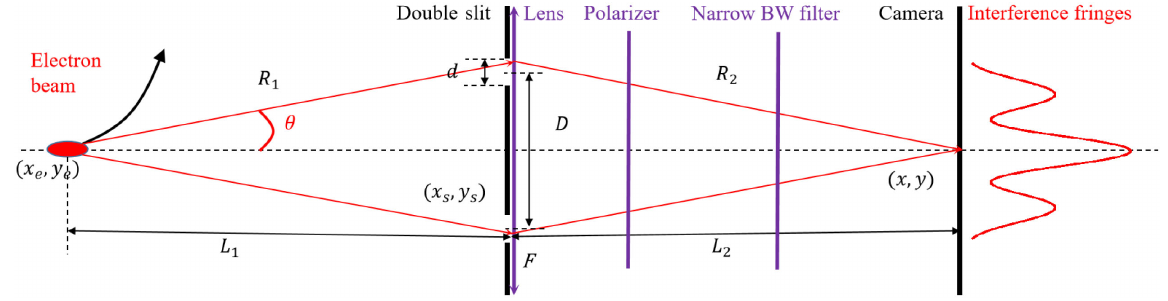
FIG. 2. Optical layout of an SRI-based electron beam size measurement system. Synchrotron radiation from the electron beam propagates through a double slit and a focusing lens, producing an interference pattern on the image plane of the lens, which is captured by a digital camera. A linear polarizer with its polarizing axis aligned horizontally and a narrow bandpass filter are used to improve the system